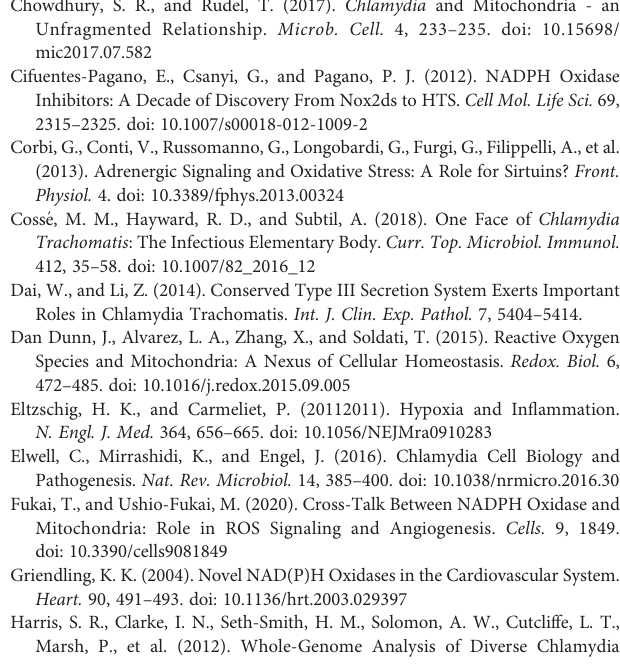
Chlamydiae (B) . Gene expression was assessed by quantitative (q) reverse transcription (RT) polymerase chain reaction (PCR), and expressed as a value of 2 D ; D ; − Ct . The quantities of NOXs were normalized to that of b -actin . Data show averages from duplicate experiments. HEp-2 cells were infected at an appropriate multiplicity of infection [MOI; GFP-expressing CtL2 (267) MOI 5; CtD: MOI 5] and cultured for 72 h. The number of bacteria in cultures was then determined by qPCR assay. The quantities of chlamydial 16S rDNA were normalized to that of b -actin. Data show means ± SD from at least three experiments. * p < 0.05 vs . the value of each positive control (PC). Supplementary Figure 2 | Effect of ML171 (2 and 10 m M) on the intracellular growth of green fl uorescent protein (GFP)-expressing CtL2 (236) in HEp-2 cells under normoxia (A) and hypoxia (B) . The HEp-2 cells were infected at MOI 5 with CtL2 (236), and then cultured for 48 h. Representative images show inclusion bodies (green) formed in infected HEp-2 cells. Bars = 100 m m. The number of bacteria was calculated by inclusion-forming unit (IFU) assay of infected cells cultured for 48 h. Data show means ± SD from at least three experiments. * p < 0.05 vs . the value of each PC. Supplementary Figure 3 | The growth of GFP-expressing CtL2 (236) in NOX4- knockdown HEp-2 cells and con fi rmation of the NOX4 knockdown by western blotting. Transfected cells were infected with CtL2 (236) for 48 h, and the numbers of IFU were veri fi ed. The upper images show inclusion bodies in the knockdown cells [NOX4-siRNA (250)] with Cont-siRNA (250) used as the control (see Methods ). The graph shows the number of IFU 48 h after infection. Data show means ± SD from fi ve fi elds per well from a single experiment. * p < 0.05 vs . each control [Cont- siRNA (250) or Cont-siRNA (50)]. The lower images show the amount of NOX4 protein in the knockdown cells (with a -tubulin used as a loading control). Supplementary Figure 4 | The establishment of Mt d -HEp-2 cells using ethidium bromide (EtBr). (A) Culture schedule of HREp-2 cells in the presence of EtBr. (B) The image (left) shows expression levels of the D-loop and COXII genes in the cells and the graph (right) shows thequanti fi edamountof COXII gene expression. (C) The image (left) shows color changes indicating the amount of NADH and NADPH in the cells, and the graph(right)showstheamountsofNADH/NADPHinthecultureofMt d -HEp-2cells.The controls were medium and parental (non-EtBr-treated) HEp-2 cells. * p < 0.05 vs . parental HEp-2